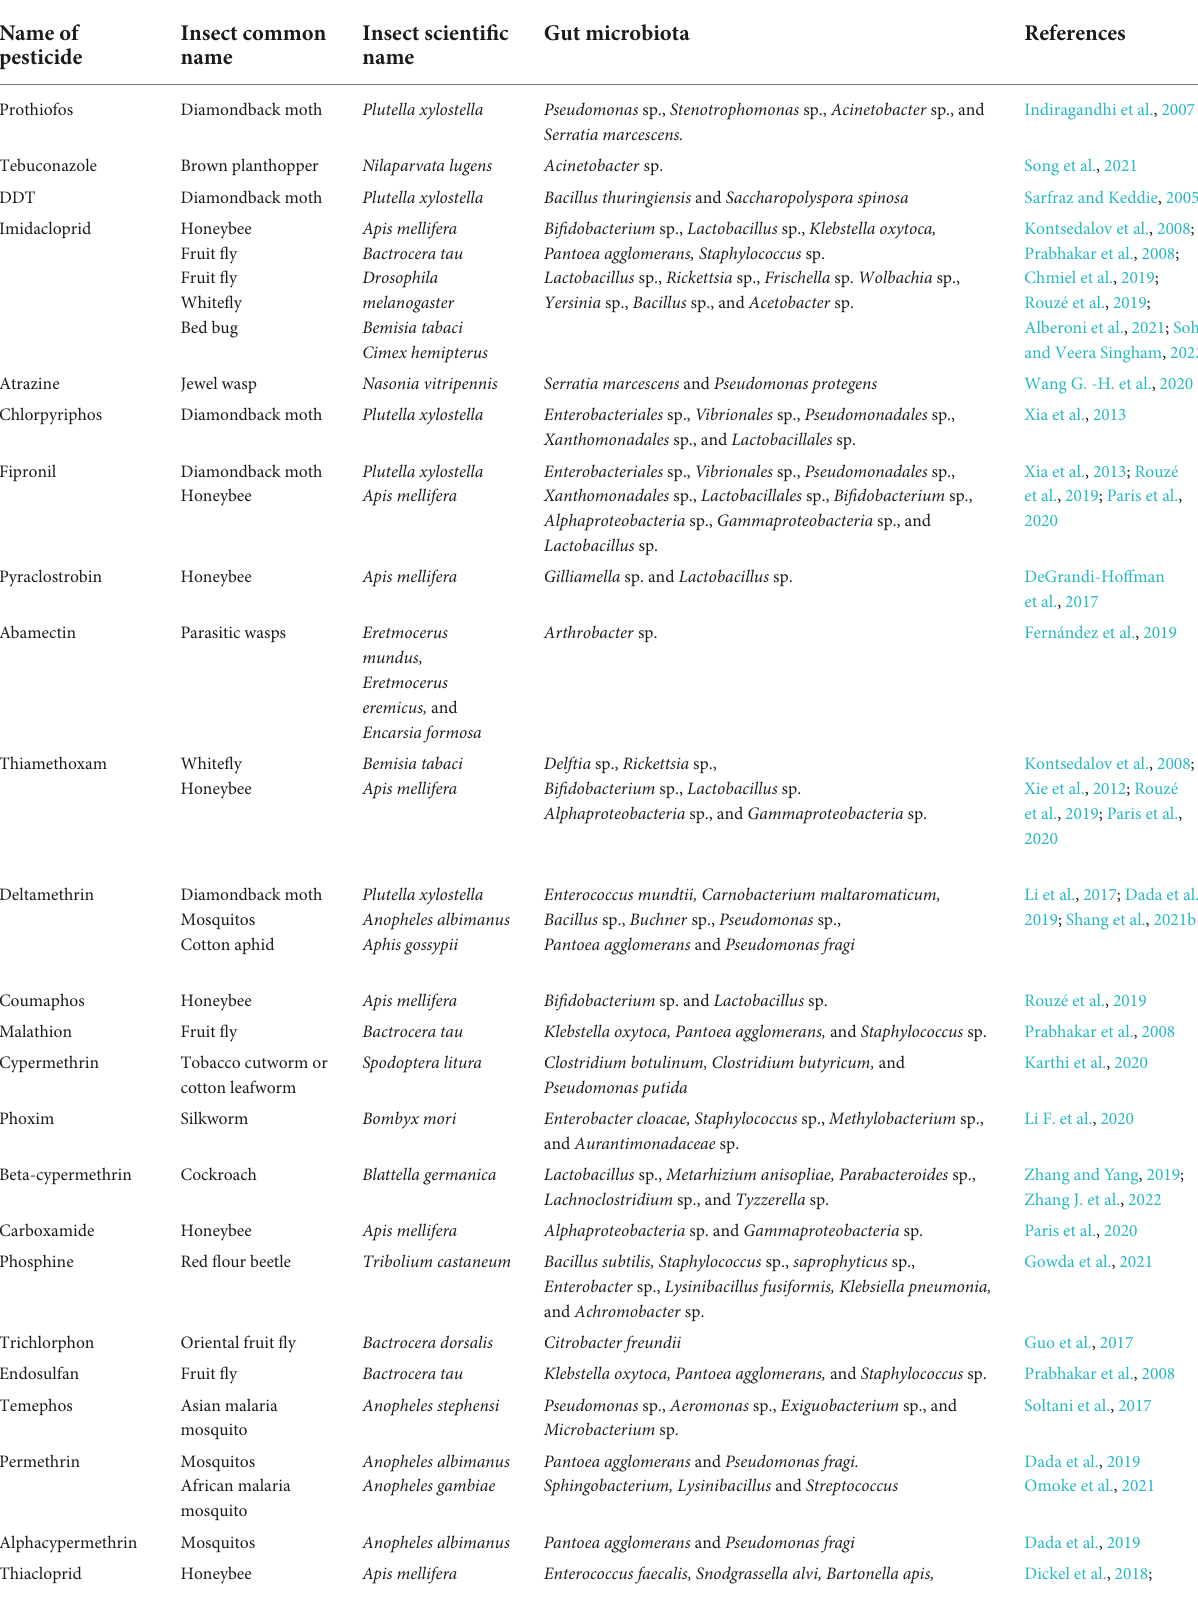
TABLE 1 Pesticide resistance cases in various insects mediated by gut microbial